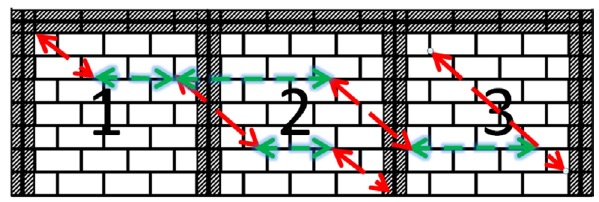
Figure 4. Cracking pattern of multi-panel walls [40].